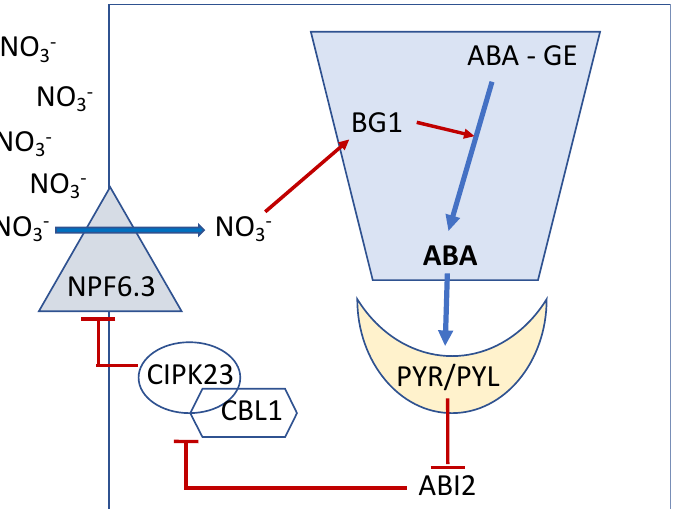
Figure 2. Overview of NO 3 − signaling via the release of bioactive ABA in the Arabidopsis root tip. Nitrate is absorbed through the transporter and sensor AtNPF6.3 (AtNRT1.1). Under high levels of